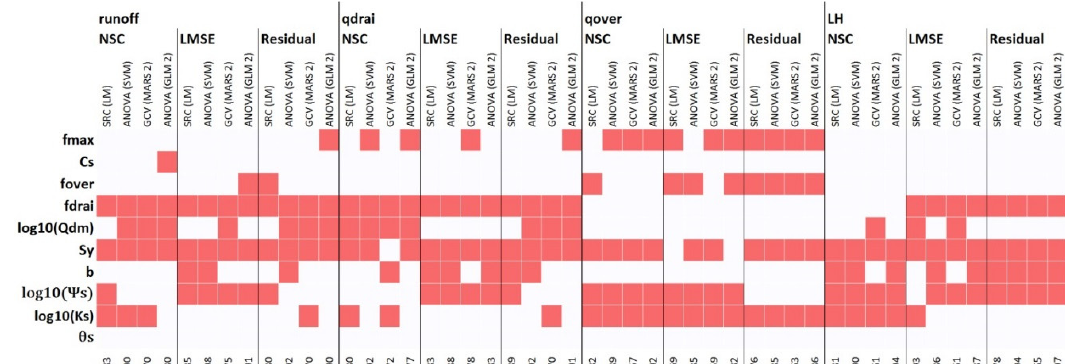
Figure 4. Proportion of sensitivity for residual in 108 months. ( a ) Residual of total runoff (runoff) ANOVA (GLM 1st order); ( b ) Residual of subsurface runoff (qdrai) ANOVA (GLM 1st order); ( c ) Residual of surface runoff (qover) ANOVA (GLM 1st order); ( d ) Residual of latent heat (LH) ANOVA (GLM 1st order).